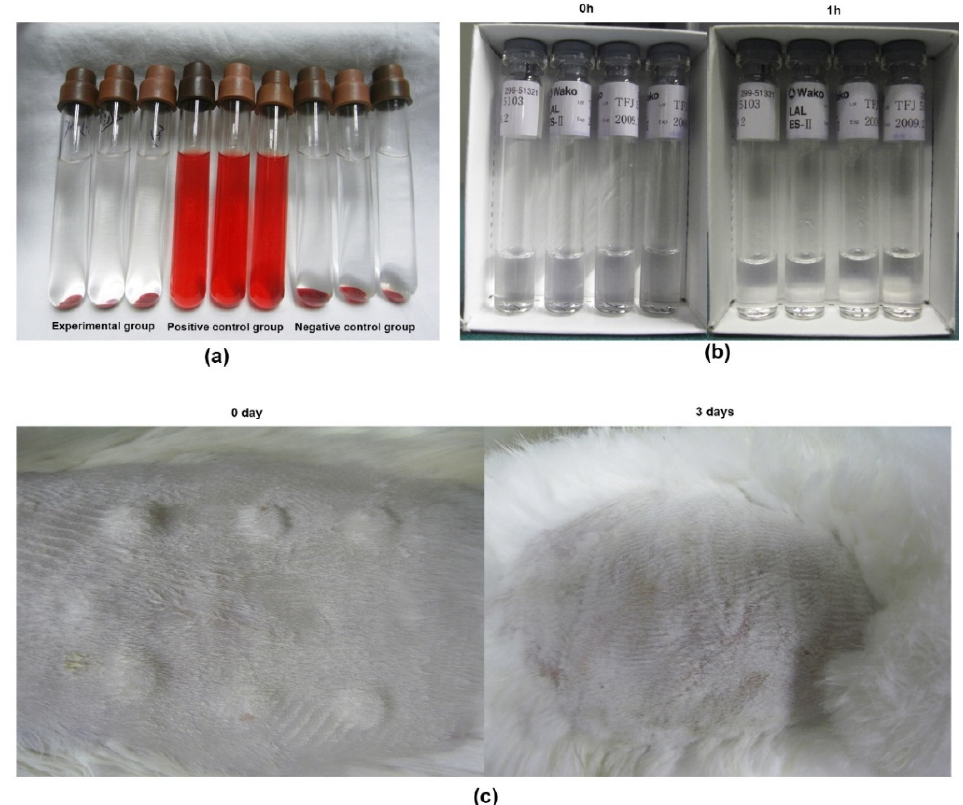
Figure 3. The biological safety of scaffolds. ( a ) The hemolysis test in the experimental group, negative control group, and positive control group. ( b ) The pyrogen test of scaffold extract. ( c ) The intradermal test of scaffold extract on rabbit.